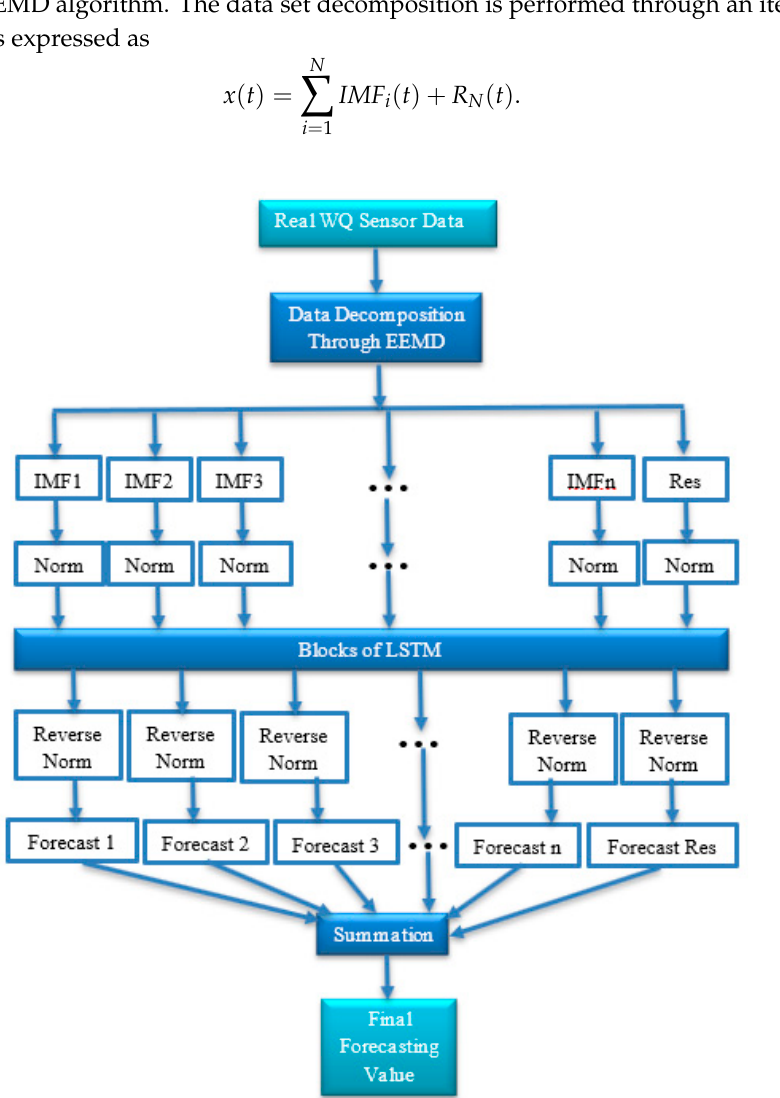
Figure 2. Hybrid ensemble empirical mode decomposition (EEMD)-based LSTM model architecture.